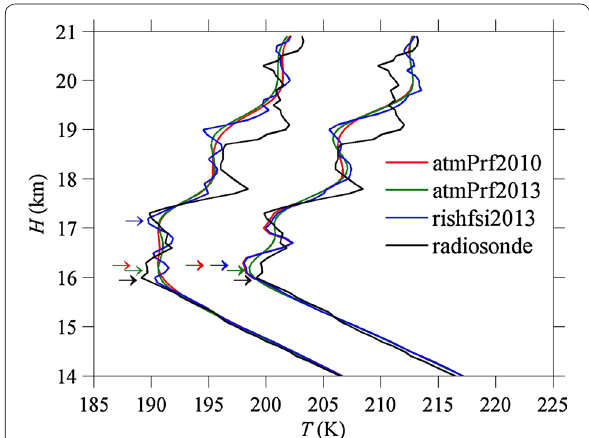
Fig. 3 Comparison of the T profiles on December 17, 2011, between the radiosonde at Cengkareng ( black line ) and two nearby COS- MIC GPS-RO by atmPrf2010 ( red line ), atmPrf2013 ( green line ) and rishfsi2013 ( blue line ), respectively. Arrows indicate the CPT altitude of each profile. Profiles on the right are shifted by 10 K